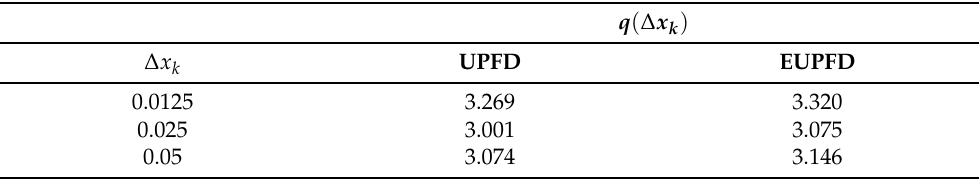
Table 2. Convergence rates for the linear ADR equation by the UPFD and EUPFD with respect to ∆ x and a fixed ∆ t = 0.001.